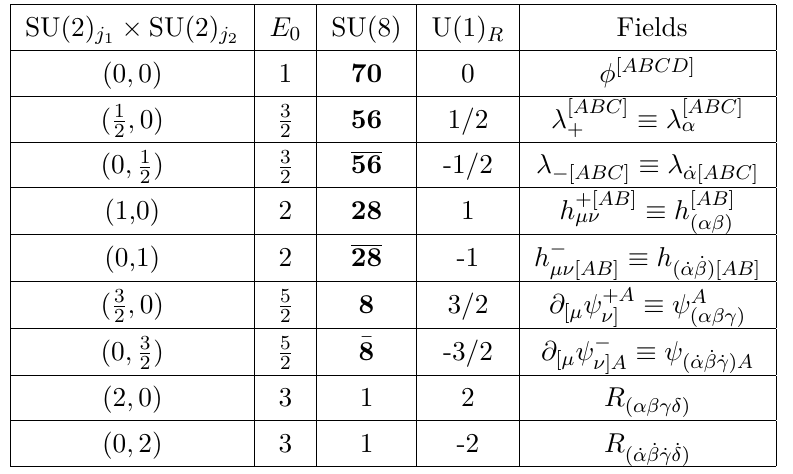
The CPT-self-conjugate doubleton supermultiplet of the superconformal algebra SU(2 , 2 | 8) The first two columns list the SU(2) j × SU(2) j and U(1) E labels of the positive energy 1 2 unitary representation of SU(2 , 2) with respect to its maximal compact subgroup. Third column lists their SU(8) R transformations and fourth column lists the U(1) R labels corresponding to their helicities. The last column lists the Lorentz covariant fields as well as their SU(8) labelling. The in- dices A, B, C, . . . = 1 , 2 , . . . , 8 are the SU(8) R -symmetry indices. The indices α, β, . . . and ˙ α, ˙ β, . . . denote the left-handed and right-handed spinorial indices of SL(2 , C ) . Round (square) brackets denote complete symmetrization (antisymmetrization) of